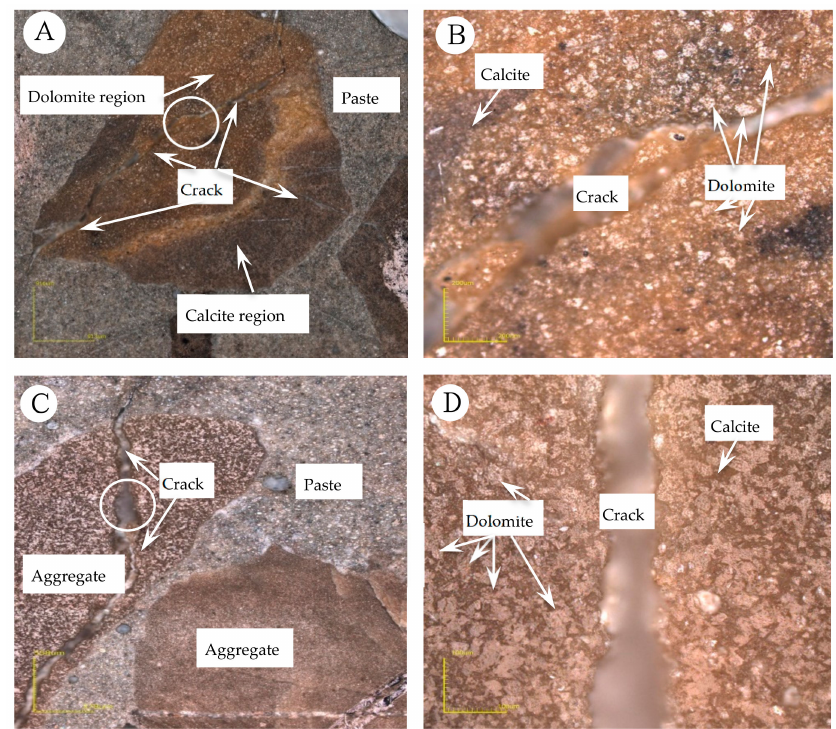
Figure 10. Expansion cracks of concrete microbars prepared with dolomitic aggregate: ( A , B )